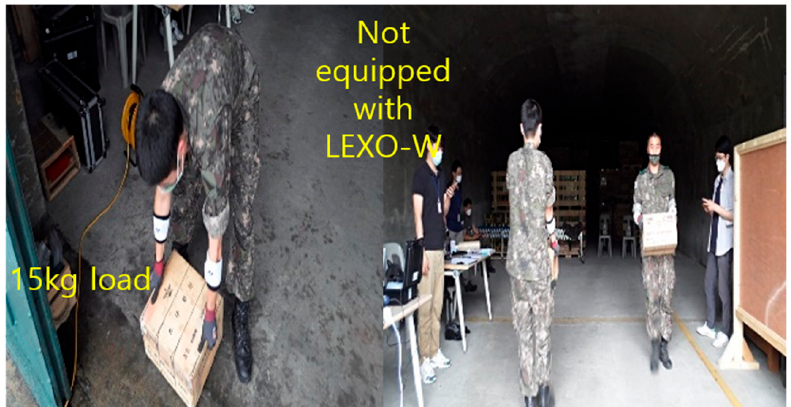
Figure 3. Not equipped with the LEXO-W with a 15 kg load.